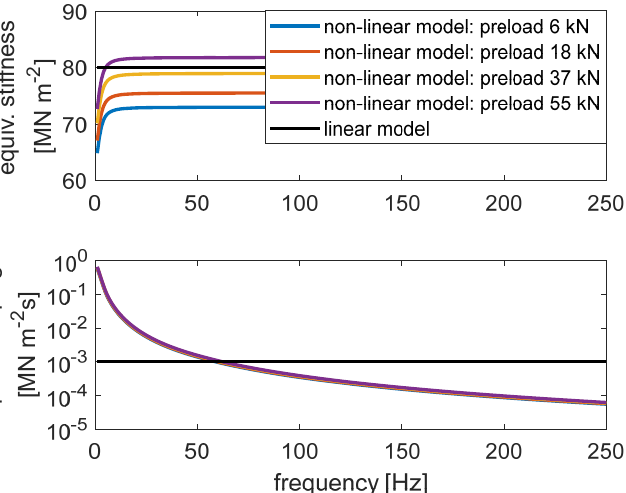
Figure 10. Equivalent stiffness ( upper plot) and viscous damping ( lower plot) computed by the non- linear and linear mechanical model of unit length of the elastomeric element of the reference ERS. The large difference in the viscous damping of the two models can have a strong effect on the simulated rail response, both on the transient phase and the steady state phase. Figure 11 represents the simulated free response of the rail subjected to a constant force of 55 kN with null initial conditions.